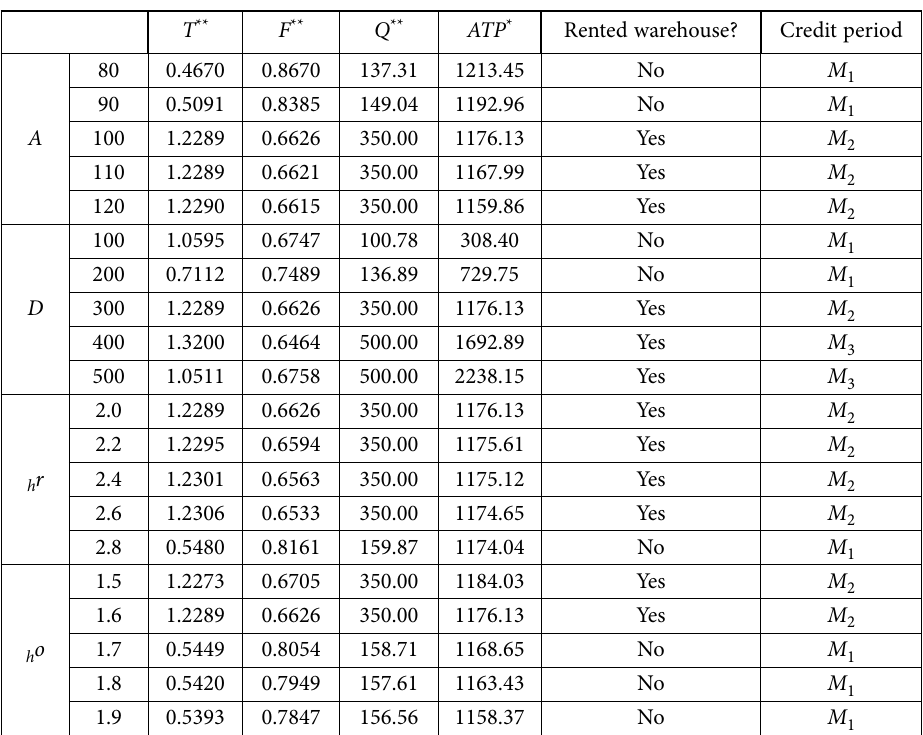
Table 6. Result of sensitivity analysis on major